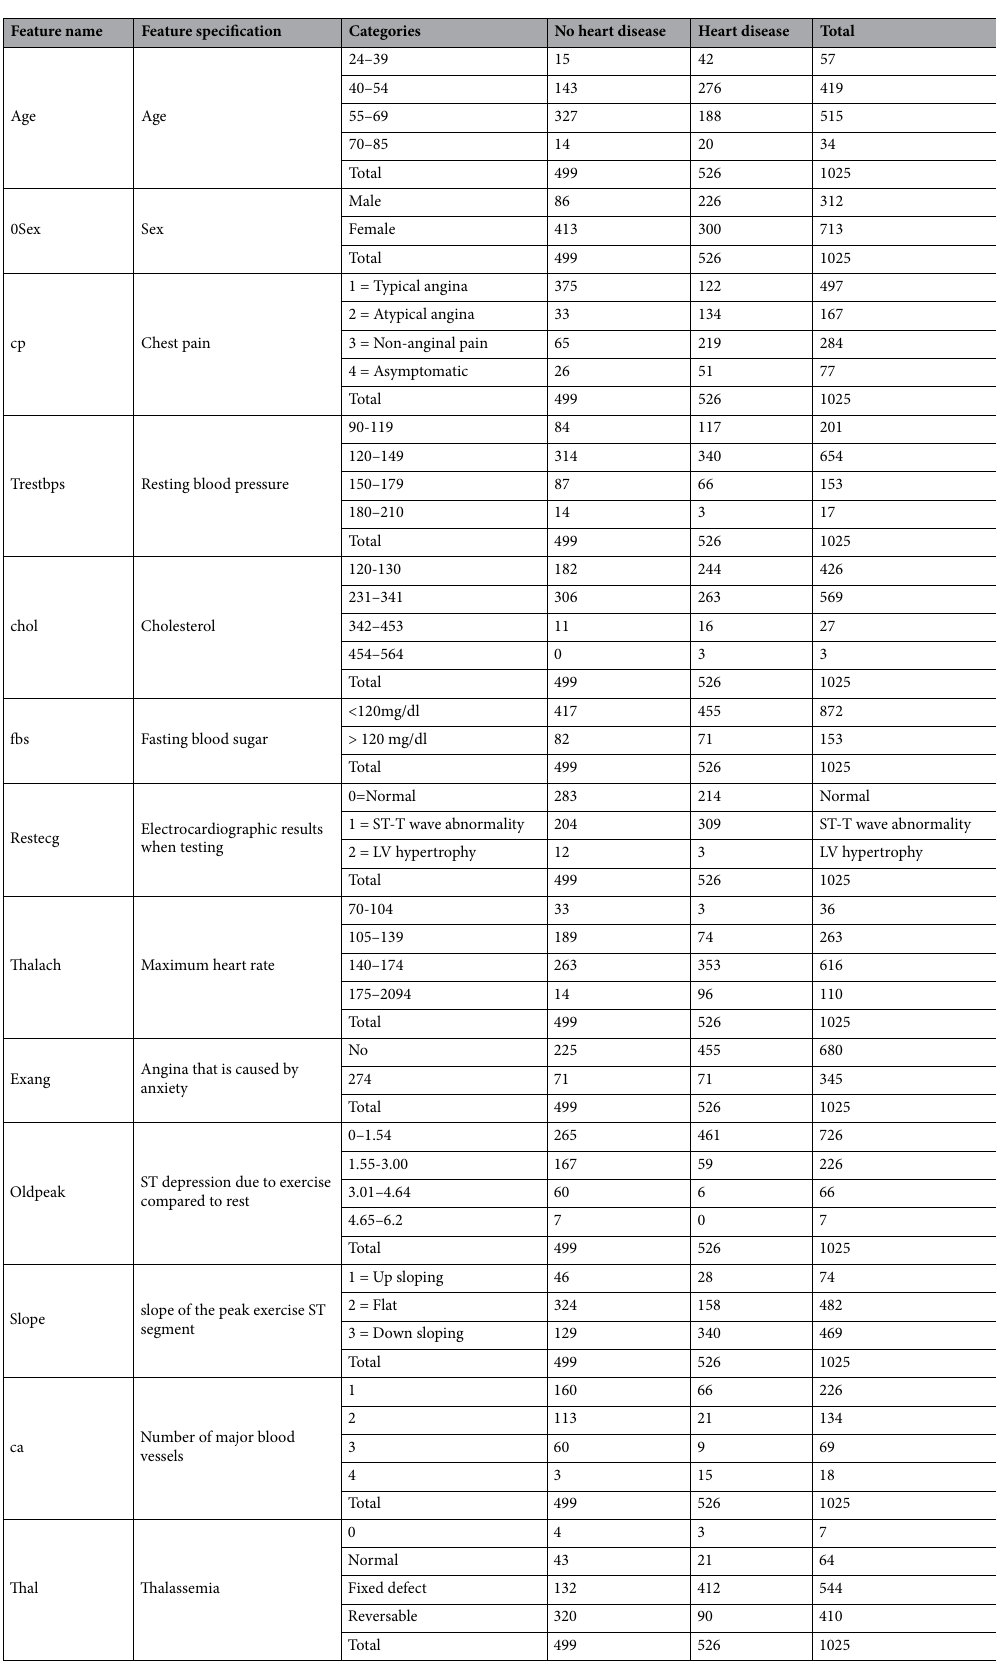
Table 1. Description of the